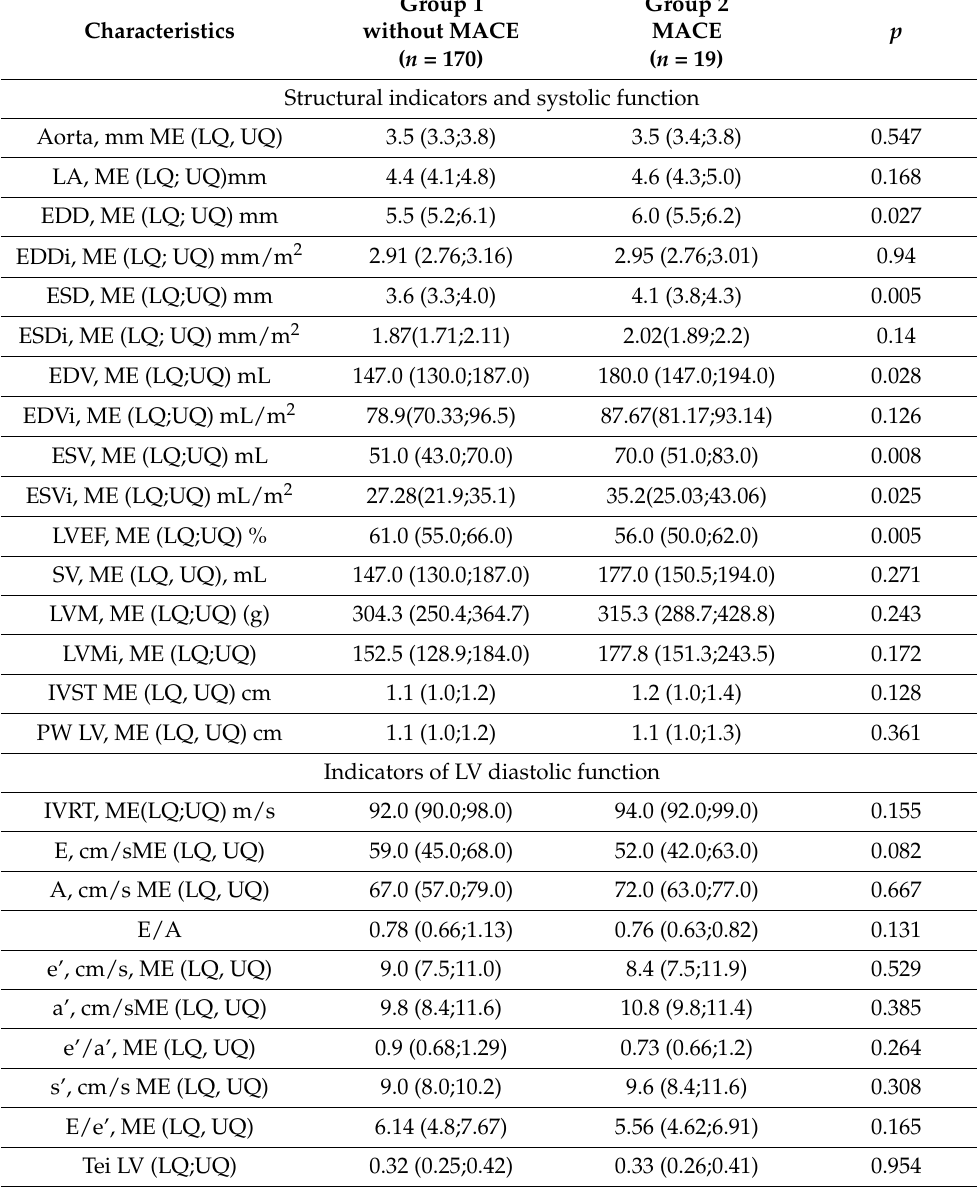
Table 2. LV indicators before surgery in patients with and without MACE 18 months after CABG.